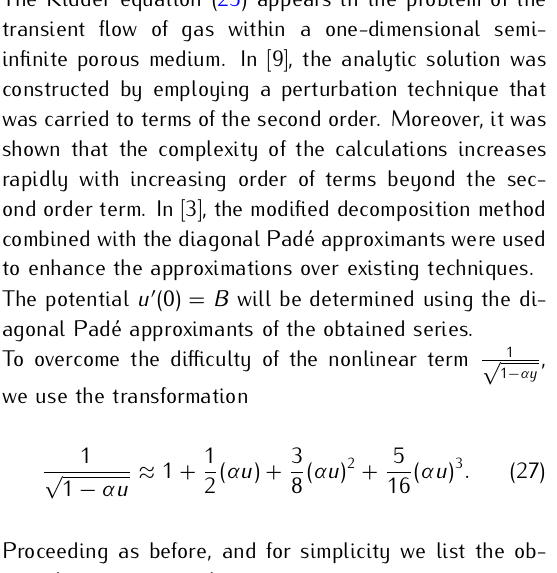
Figure 3. Padé approximant